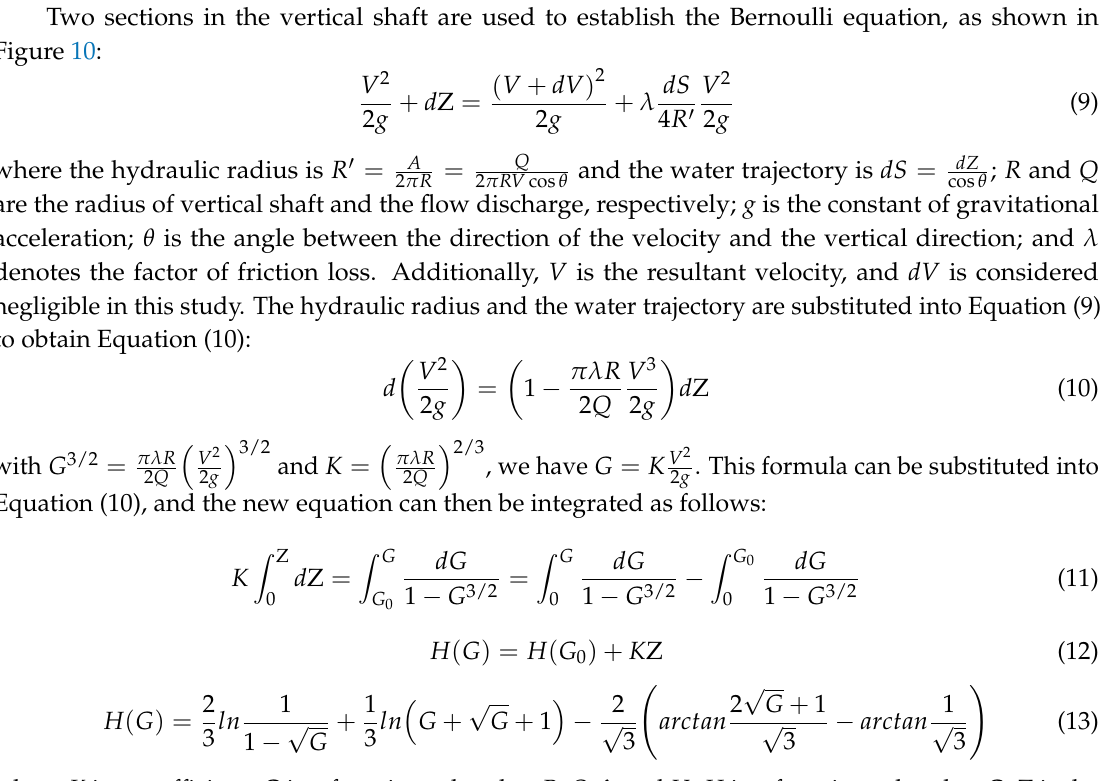
Figure 9. Resultant velocity field in the numerical simulation (P = 0.1%).